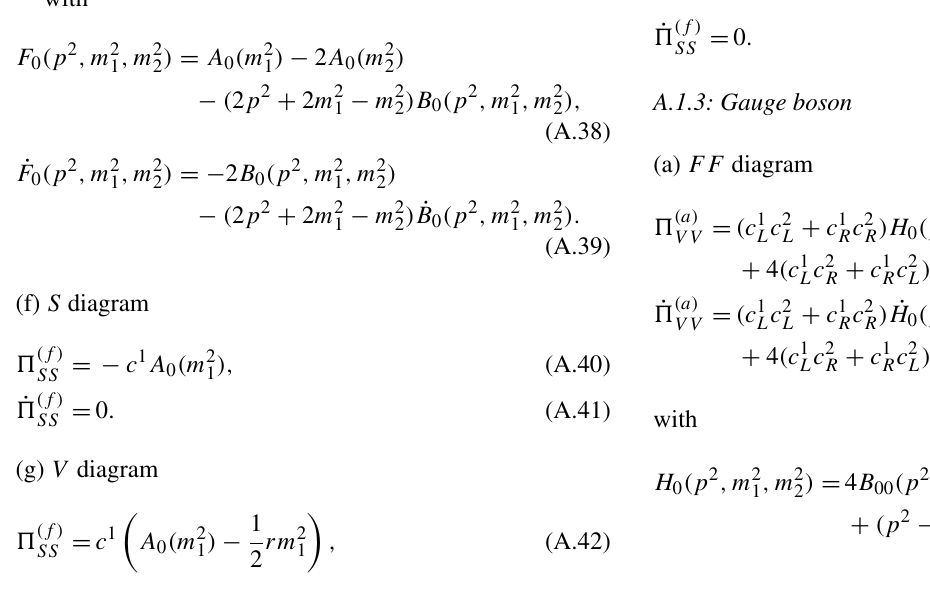
Fig. 20 Generic diagrams contributing to S → V V decays